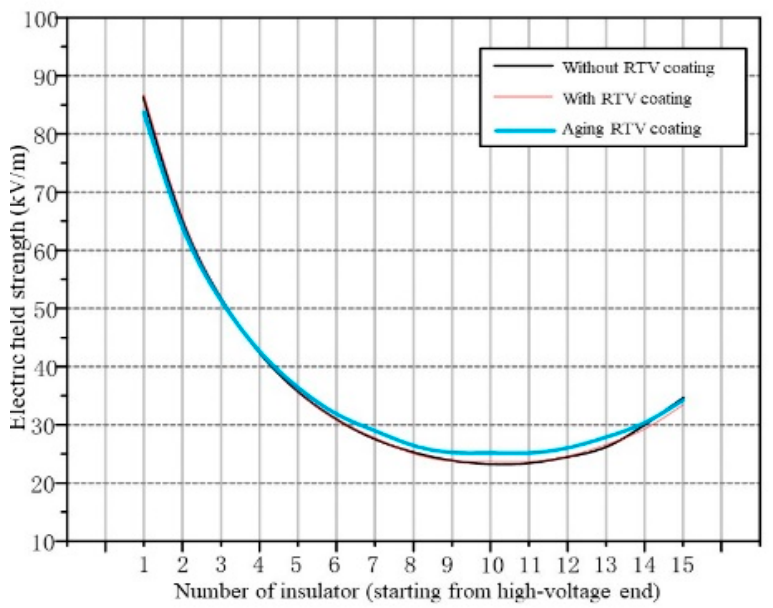
Figure 4. Space electric field distribution of insulator strings with deteriorated pieces.